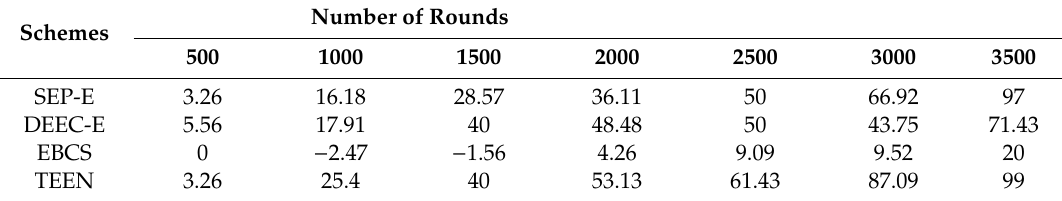
Figure 9. Packet delivery ratio (PDR) (%) against number of communication rounds. Table 14. Percentage improvement of HFECS in terms of PDR.